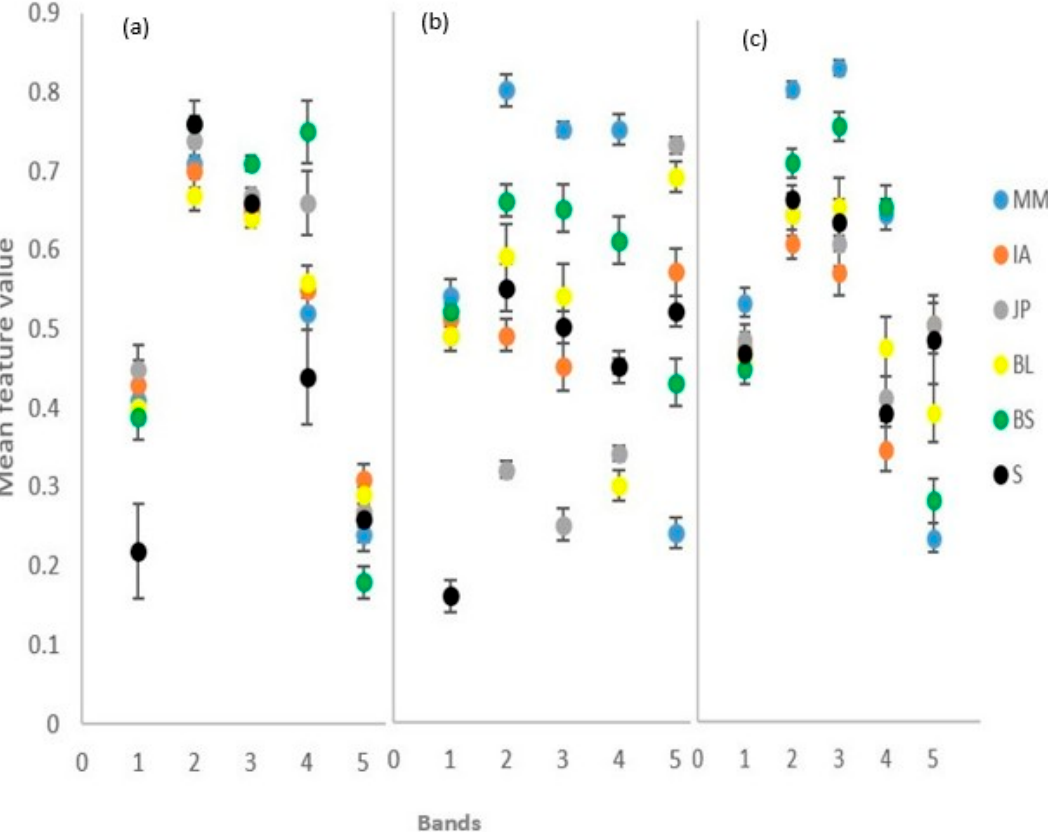
Figure 6. Species separability in band spectral metrics bands (1, brightness; 2, maximum difference; 3, NDVI; 4, GCC; 5 RCC): ( a ) 25.05.21 image, ( b ) 15.08.21 image; and ( c ) 24.10.21 image. S = shadow.